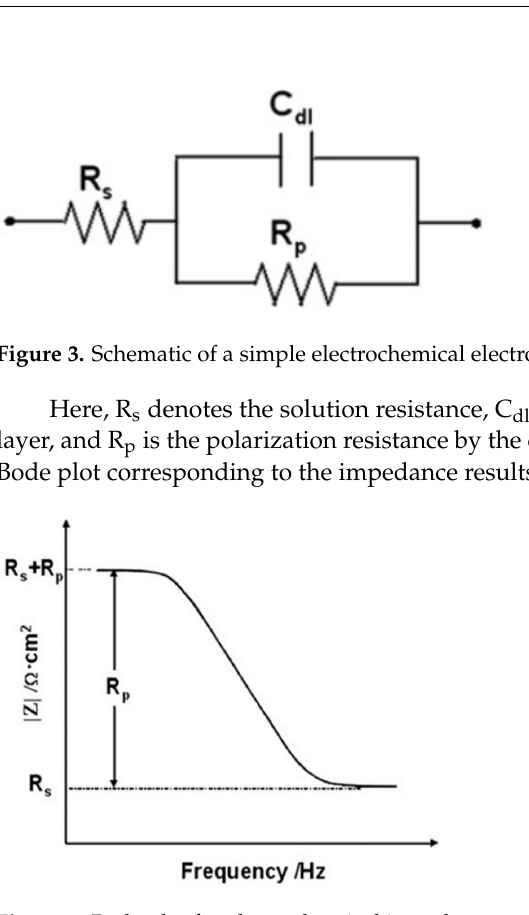
Figure 4. Bode plot for electrochemical impedance spectroscopy measurement.